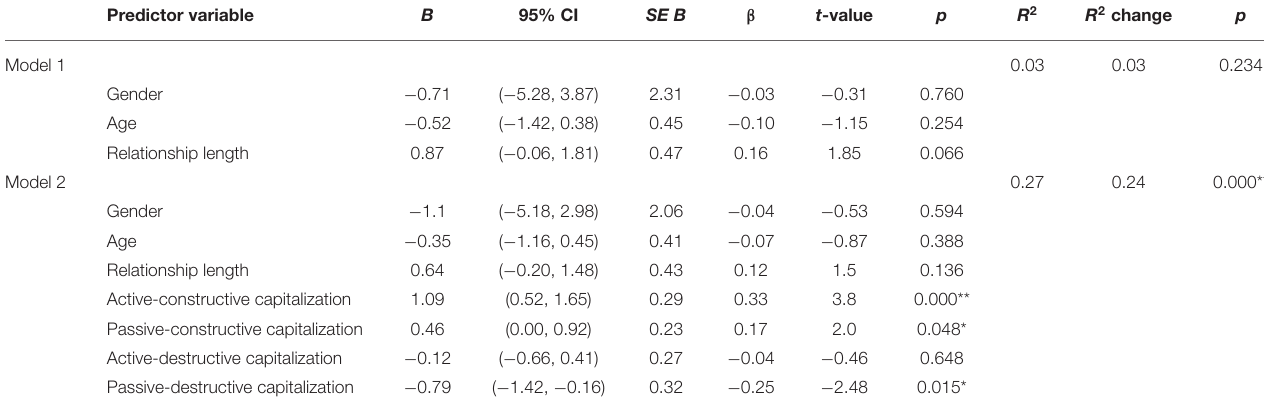
TABLE 5 | Capitalization responses as predictors of relationship satisfaction. Predictor